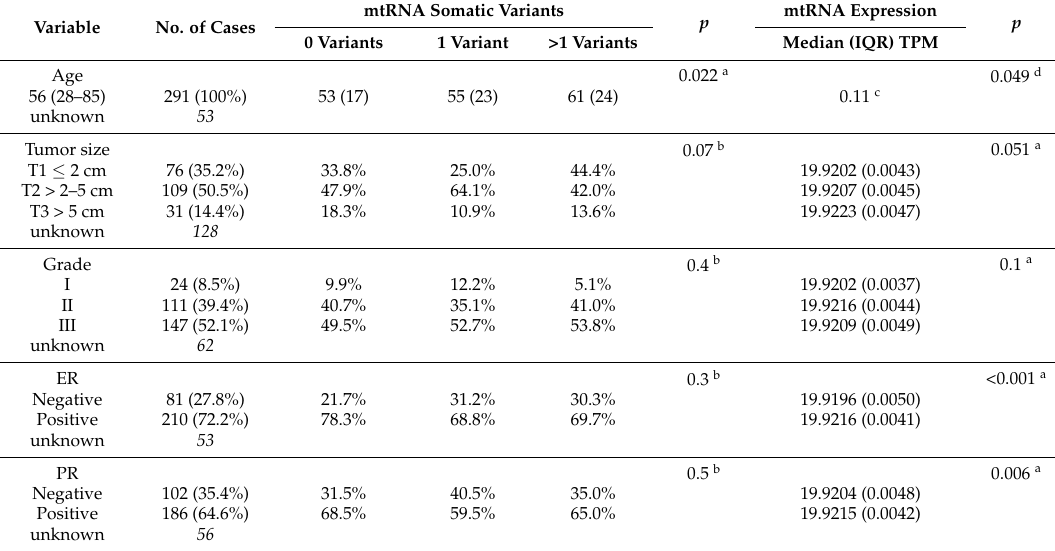
Table 1. Association between number of somatic tumor mtRNA variants or expression of the entire mtDNA and clinicopathological